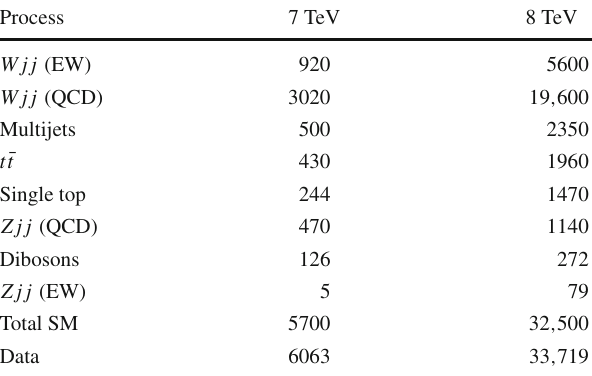
Table 3 Observed data and predicted SM event yields in the signal region. The MC predictions are normalized to the theoretical cross sec- tions in Table 2. The relative uncertainty of the total SM prediction is O (10%)